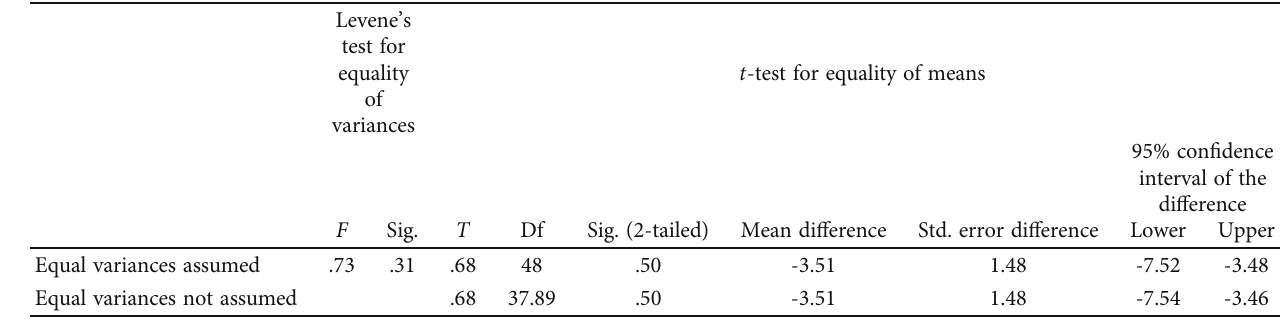
Table 3: Independent sample t -test of both groups in the speaking pretests.